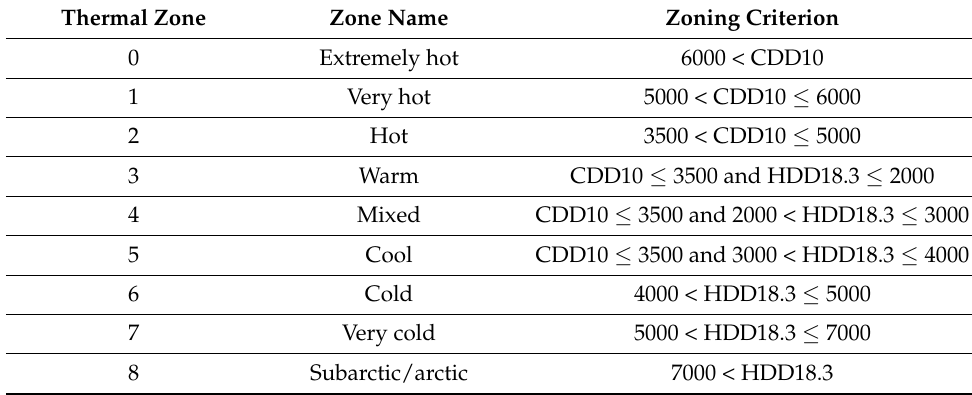
Table 2. Thermal climate zone definitions of the ASHRAE